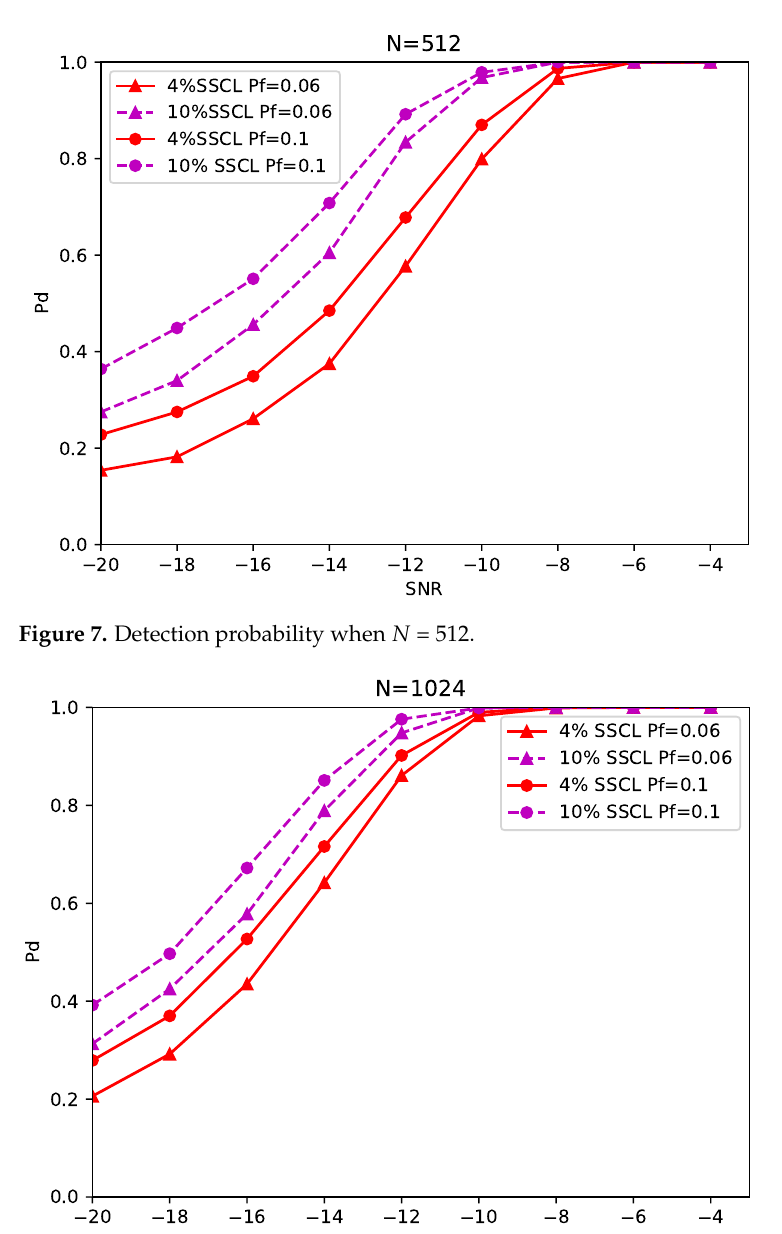
Figure 8. Detection probability when N =